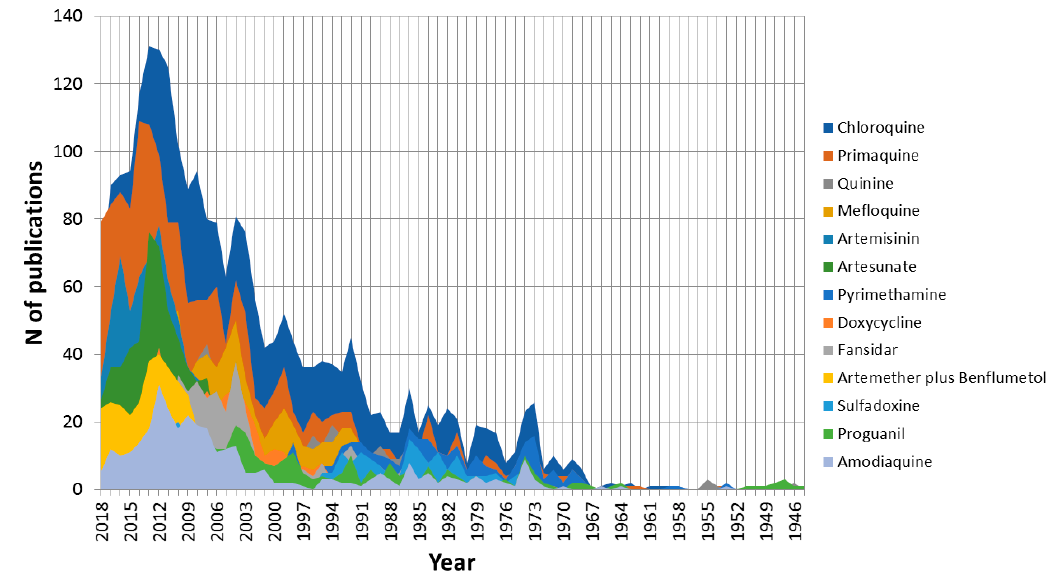
Figure 8. Time progression of antimalarial drugs in the fight against malaria caused by P. vivax.